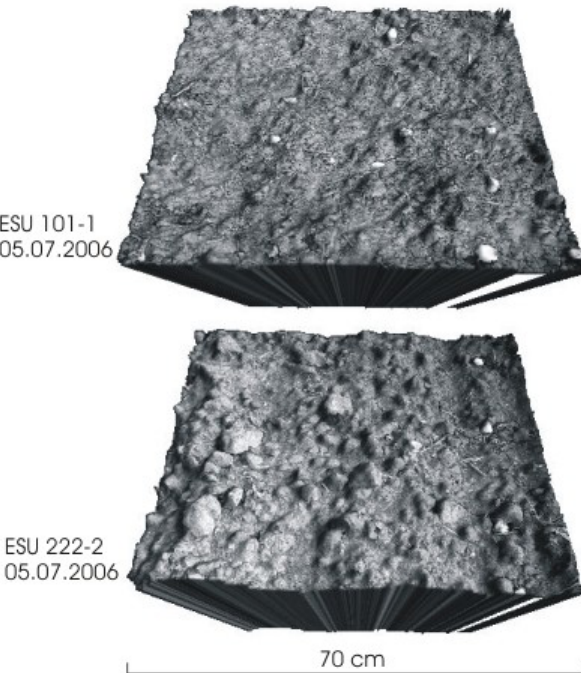
Figure 3. DSMs of a soil surface under Winterrape (ESU 101-1) and under Maize (222-2) after receiving 87 mm precipitation since monitoring.